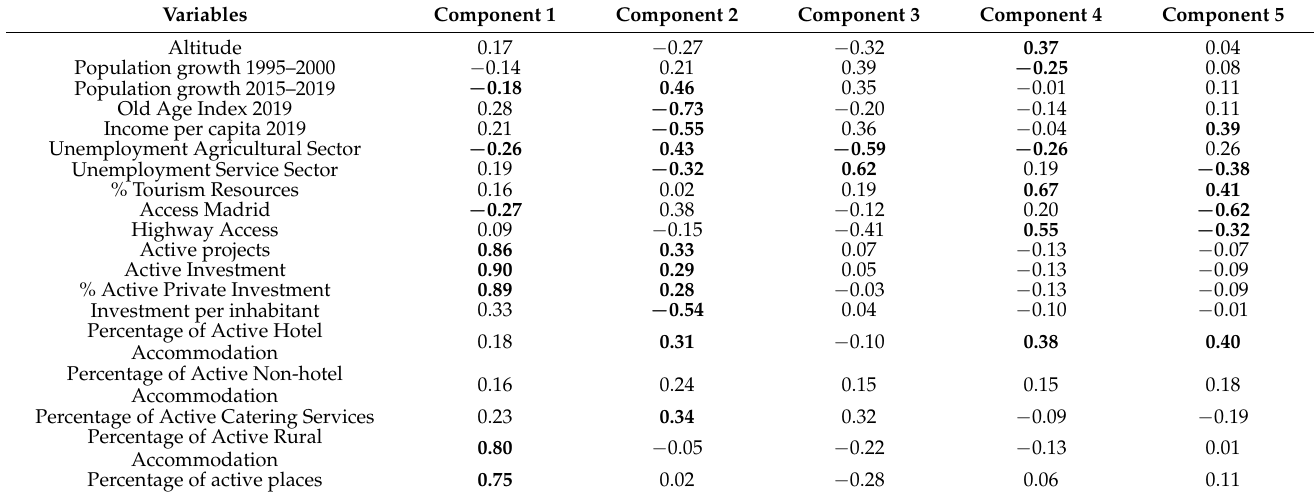
Figure 2. Scree plot. Table 5. Factor weights of the